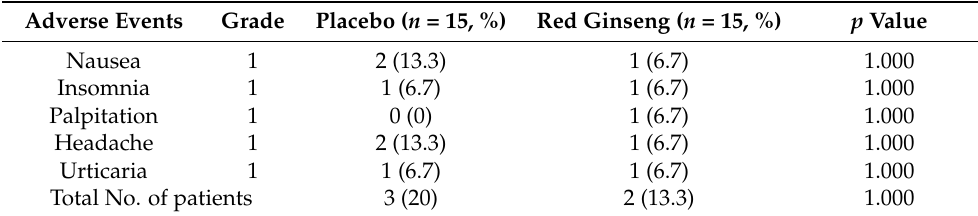
Table 3. Adverse events after consumption of red ginseng or placebo.